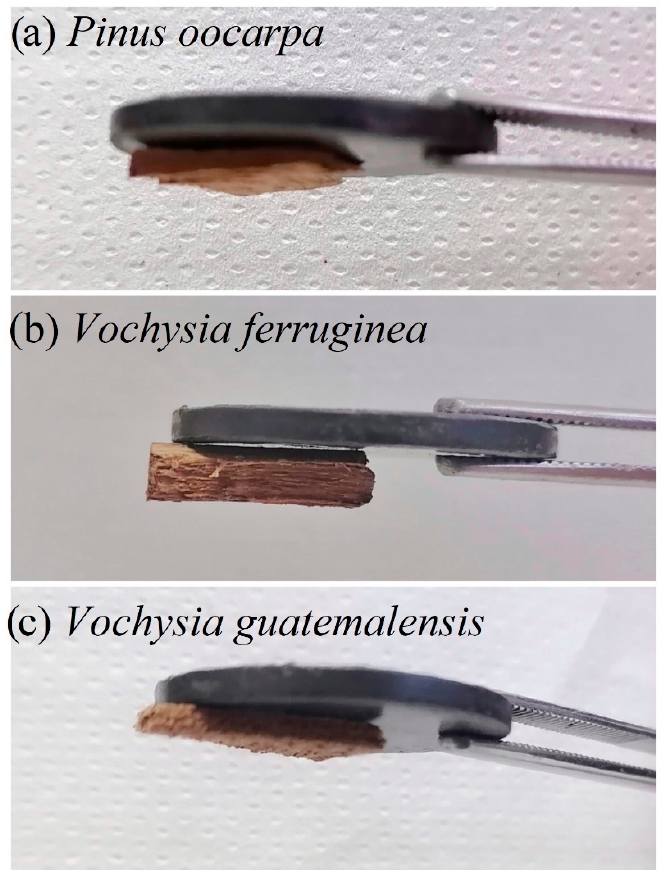
Figure 6. Magnetic wood samples from fast-growth plantations in Costa Rica. The figure shows a permanent magnet attracting the wood as a way to show the magnetic behavior of the